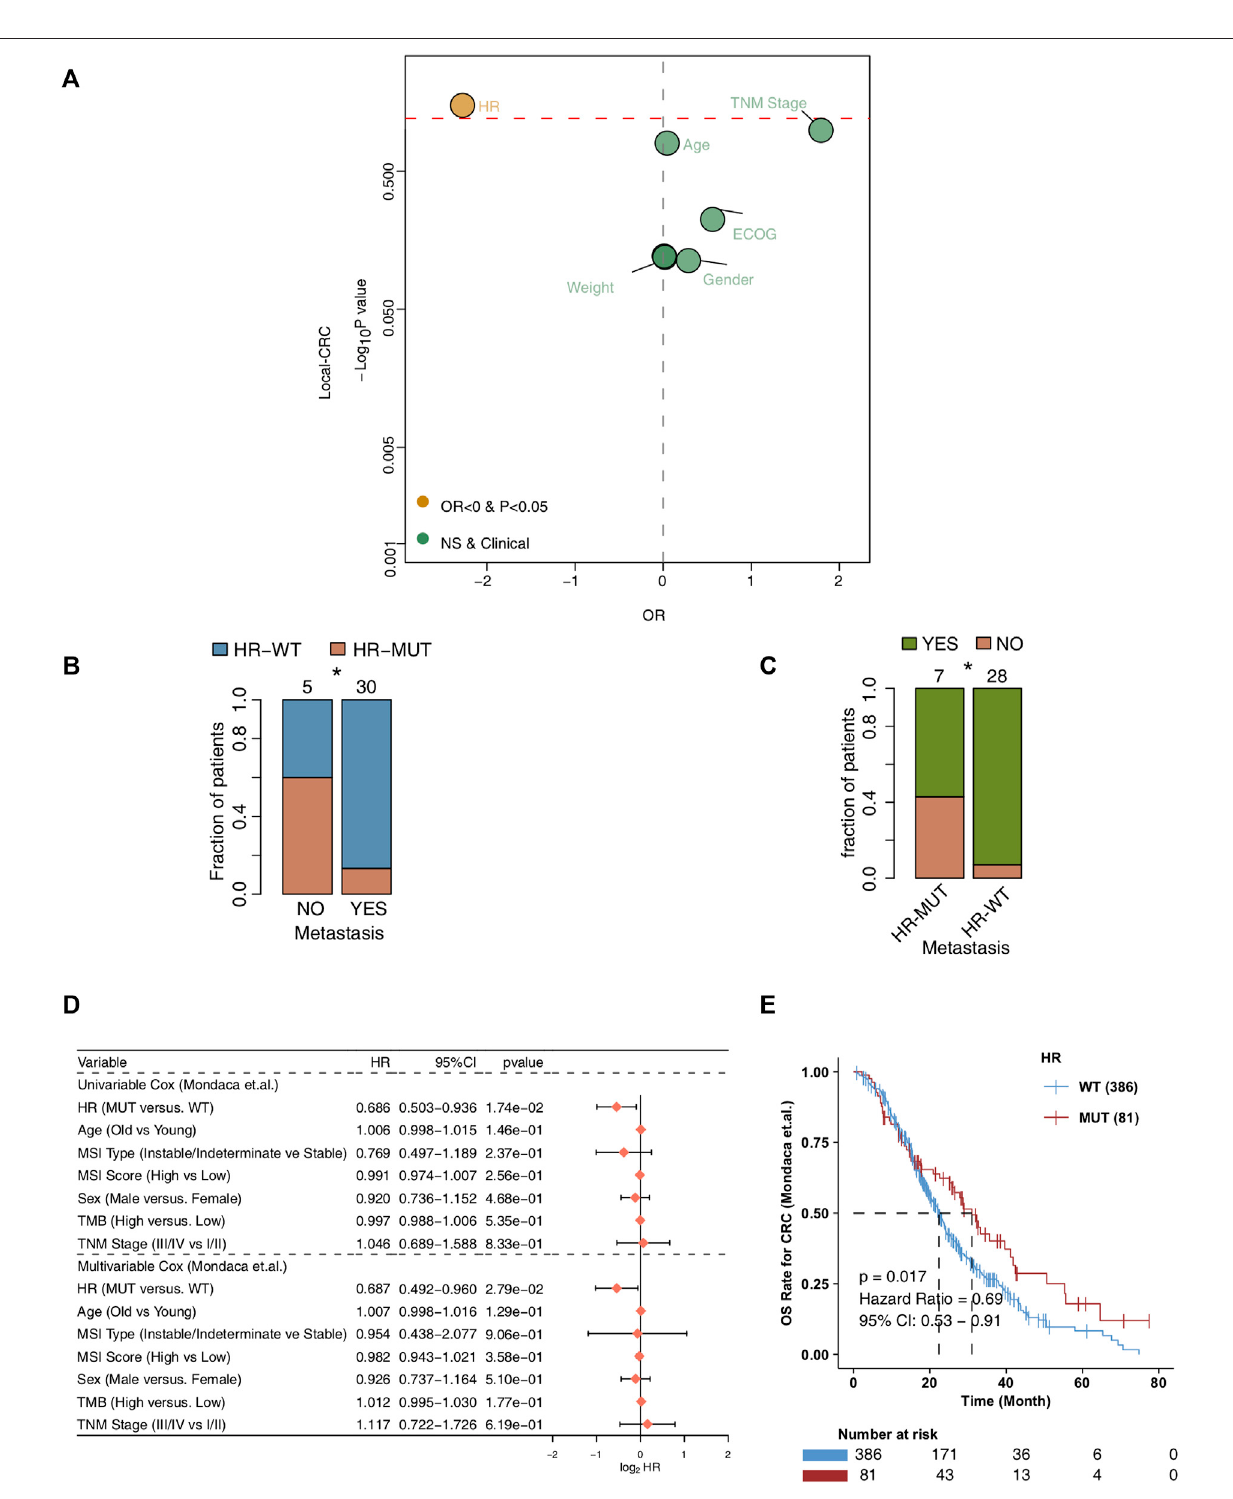
FIGURE2| TheprognosisvalueoftheHR-MUTgroup (A) .LogisticregressionmodeloftheHR-MUTgroupandclinicalcharacteristicsintheLocal-CRCcohort (B) . AcomparisonbetweentheHRmutationstatusesofthemetastasis-yesgroupandmetastasis-nogroup (C) .Acomparisonbetweenthetumormetastasisstatusesofthe HR-MUT and HR-WT groups (D) . The univariable and multivariable cox regression model of the HR-MUT group and clinical characteristics in the Mondaca-CRC cohort (E) . KM curve showed the HR-MUT CRC patients displayed a signi fi cant improvement in OS time compared with the HR-WT CRC patients in the Mondaca-CRC cohort (* p <